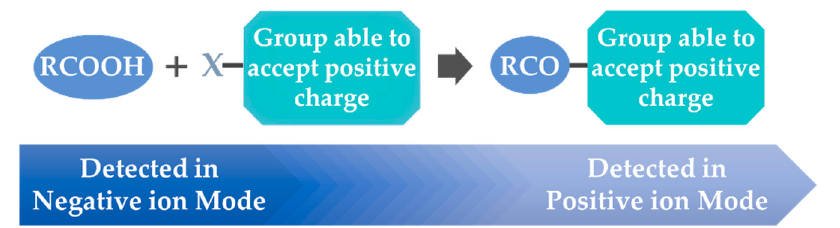
Figure 3. Basic principle of FA derivatization for its charge